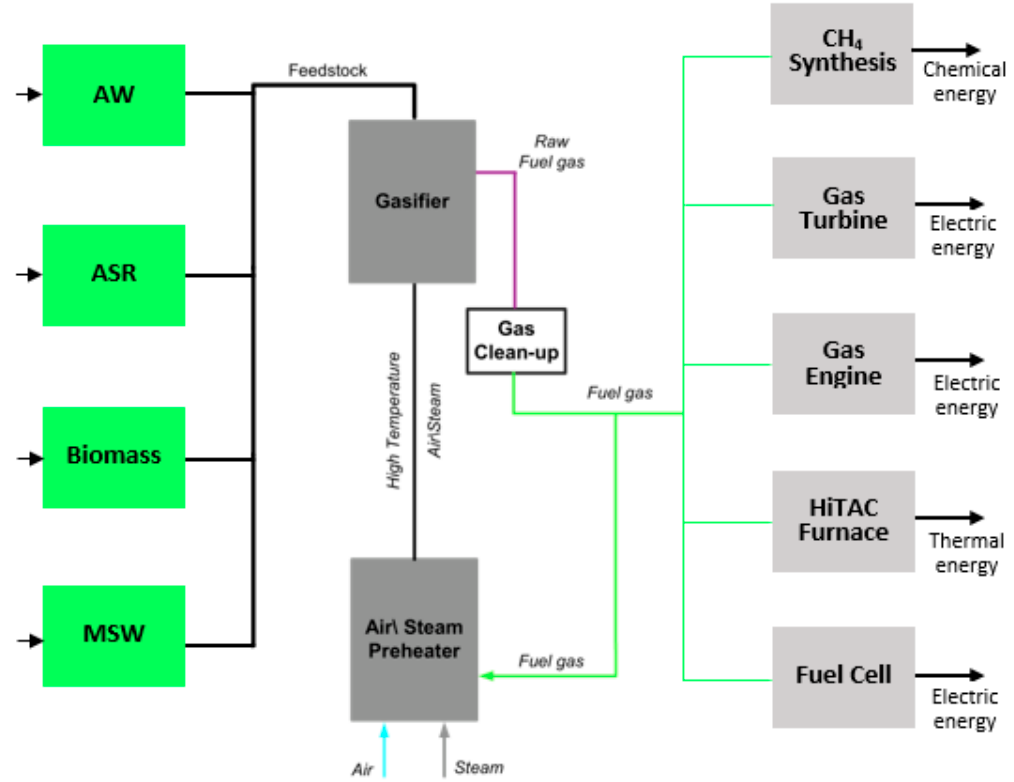
Figure 5. General schematics of HiTAG/HiTSG plant for different utilization alternatives of the fuel gas obtained from biomass and waste (AW—Animal waste; ASR—Automotive shredder residues; MSW—Municipal solid waste). High calorific gas produced in the process can be used as fuel gas in